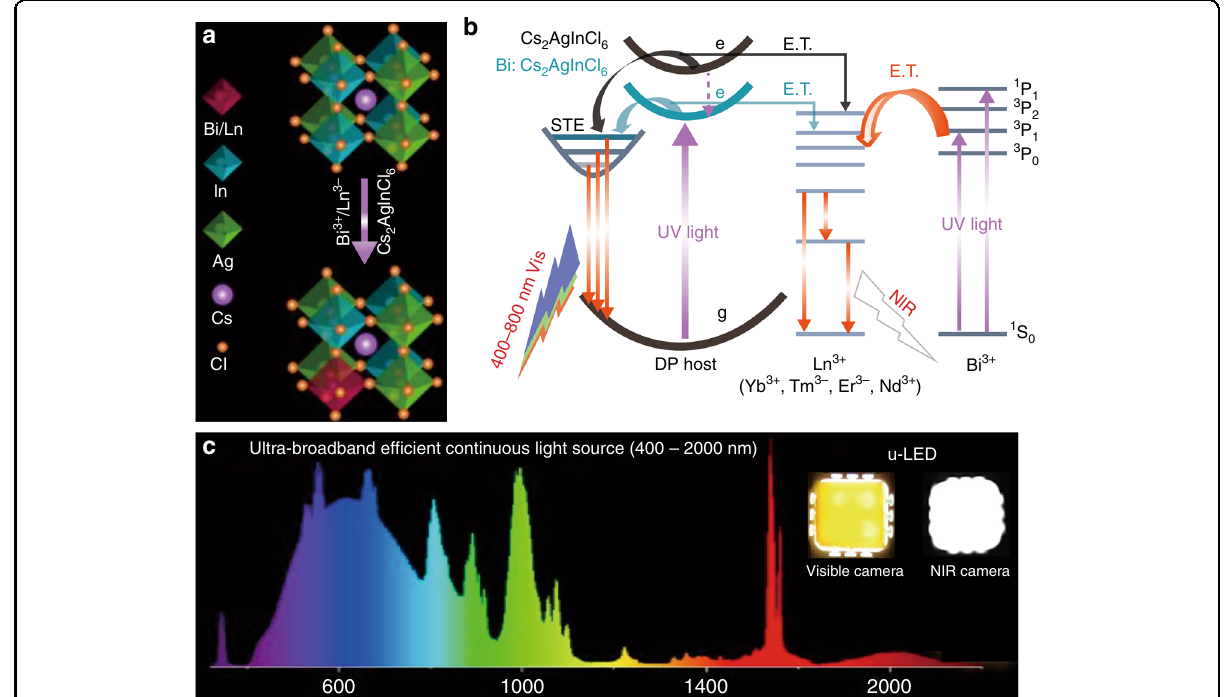
Fig. 1 u -LED relying on the synergy of (STE) recombination and Ln 3 + dopants ’ 4f-4f transitions of the multi-Ln 3 + -DiG. a Structure diagram of Bi/Ln:Cs 2 AgInCl 6 DPs. b The ultra-broadband emission mechanisms in Bi/Ln:Cs 2 AgInCl 6 DPs. c PL spectrum of the u-LED device. The inset is the photographs of the multi-Ln 3 + -DiG u-LED by visible camera (yellow) and NIR camera